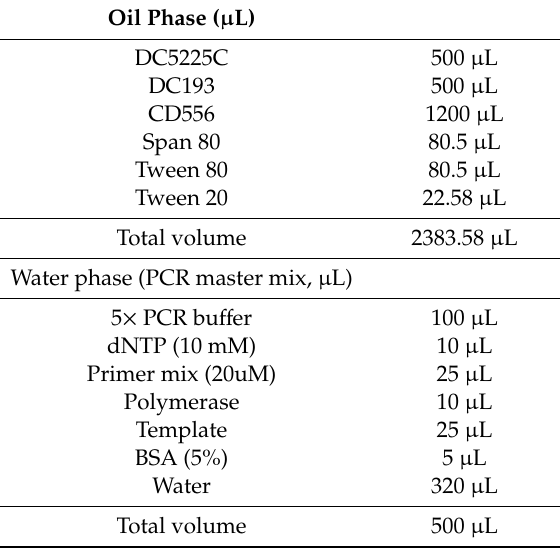
Table 1. The recipe of the emulsion